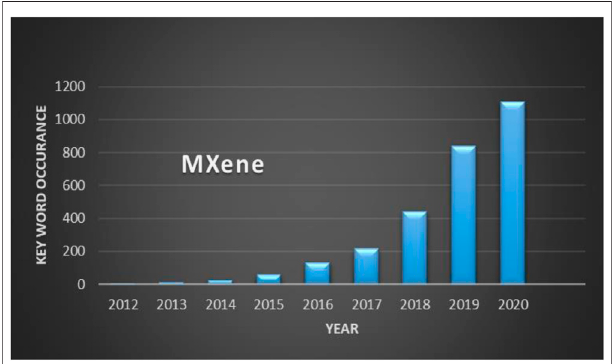
FIGURE 7 | Keyword occurrences for MXene in Scopus documents from 2012 to 2020.